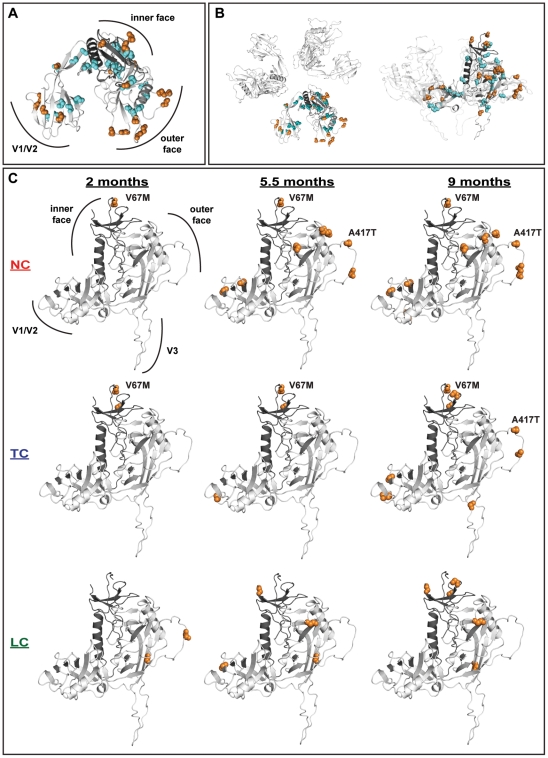
Distribution of significantly selected mutations on gp120.Mutated sites were mapped on a molecular model of SIV gp120. The inner domain of the monomer is displayed in dark grey. Positively- and negatively-selected mutations are highlighted as orange and cyan spheres, respectively. (A) Combined analysis of the localization of the positively- and negatively-selected mutations found at 2, 5.5 and 9 months. The gp120 monomer is oriented with the V3 domain pointing away from the viewer. In contrast to the conserved sites that are mostly localized within the core of the monomer, the positively-selected mutations are predominantly exposed on the surface of gp120. (B) The selected mutations are highlighted in a molecular model of the gp120 trimer viewed with the same orientation as in 8A (left) or ‘from the side’ following a 90° rotation (right). (C) Progressive and clustered appearance of the positively-selected mutations analyzed individually for each of the three different monkey groups LC, TC and NC at 2, 5.5 and 9 months. The inner and outer as well as the V1/V2 and V3 domains are indicated. The orientation of the monomer was slightly tilted with respect to (B) and the occurrences and localizations of the V67M and A417T mutations are highlighted.